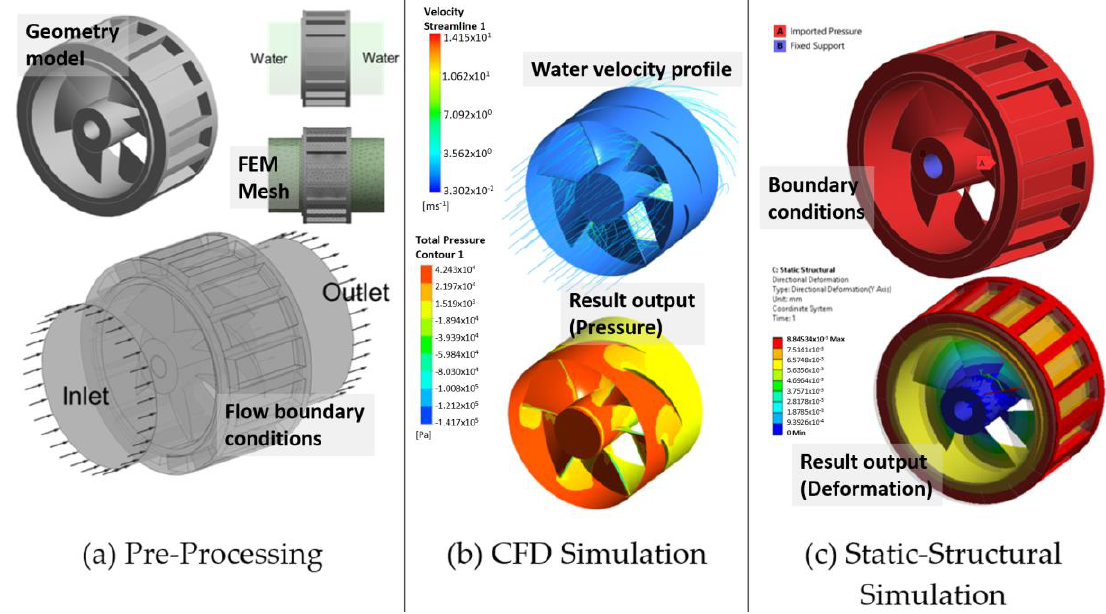
Figure 10. Overview of the stages involved for the development of the simulation model. ( a ) Pre- processing; ( b ) CFD simulation; ( c ) static-structural simulation.